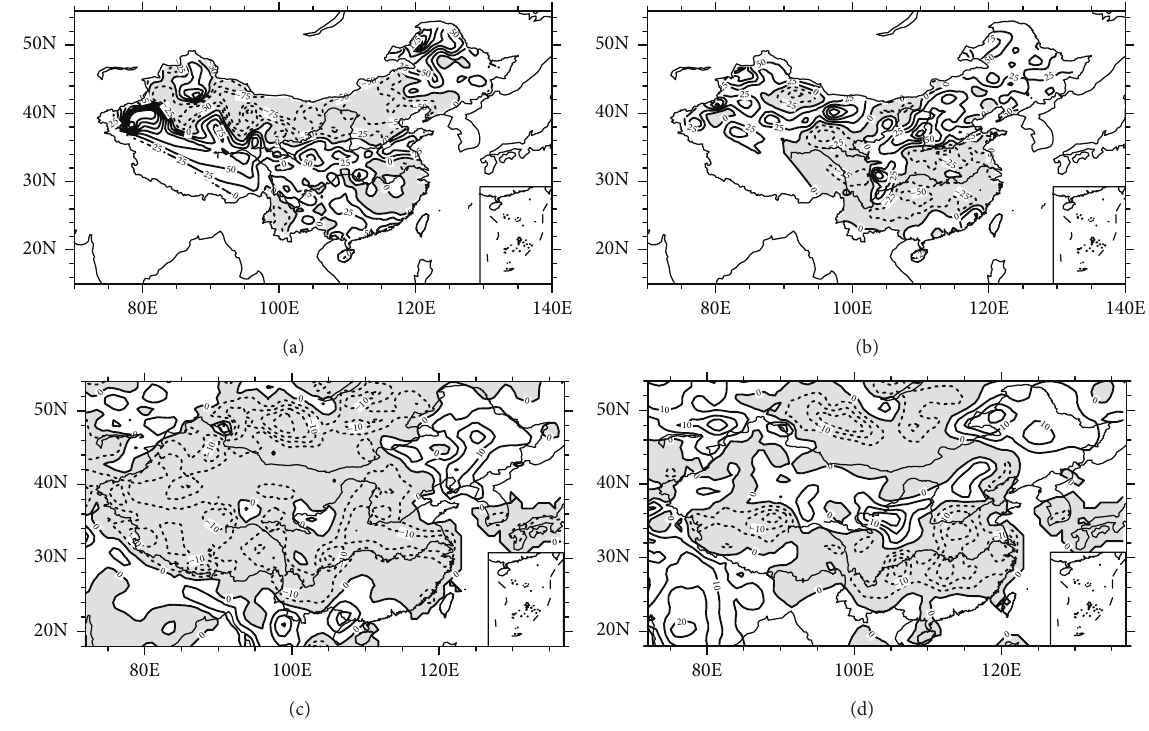
Figure 12: The percentage of precipitation anomalies in China in (a) spring and (b) summer of 2013 and the percentage of volumetric soil water anomalies in China in (c) spring and (d) summer of 2013. Shaded area denotes the negative percentage of precipitation and volumetric soil water